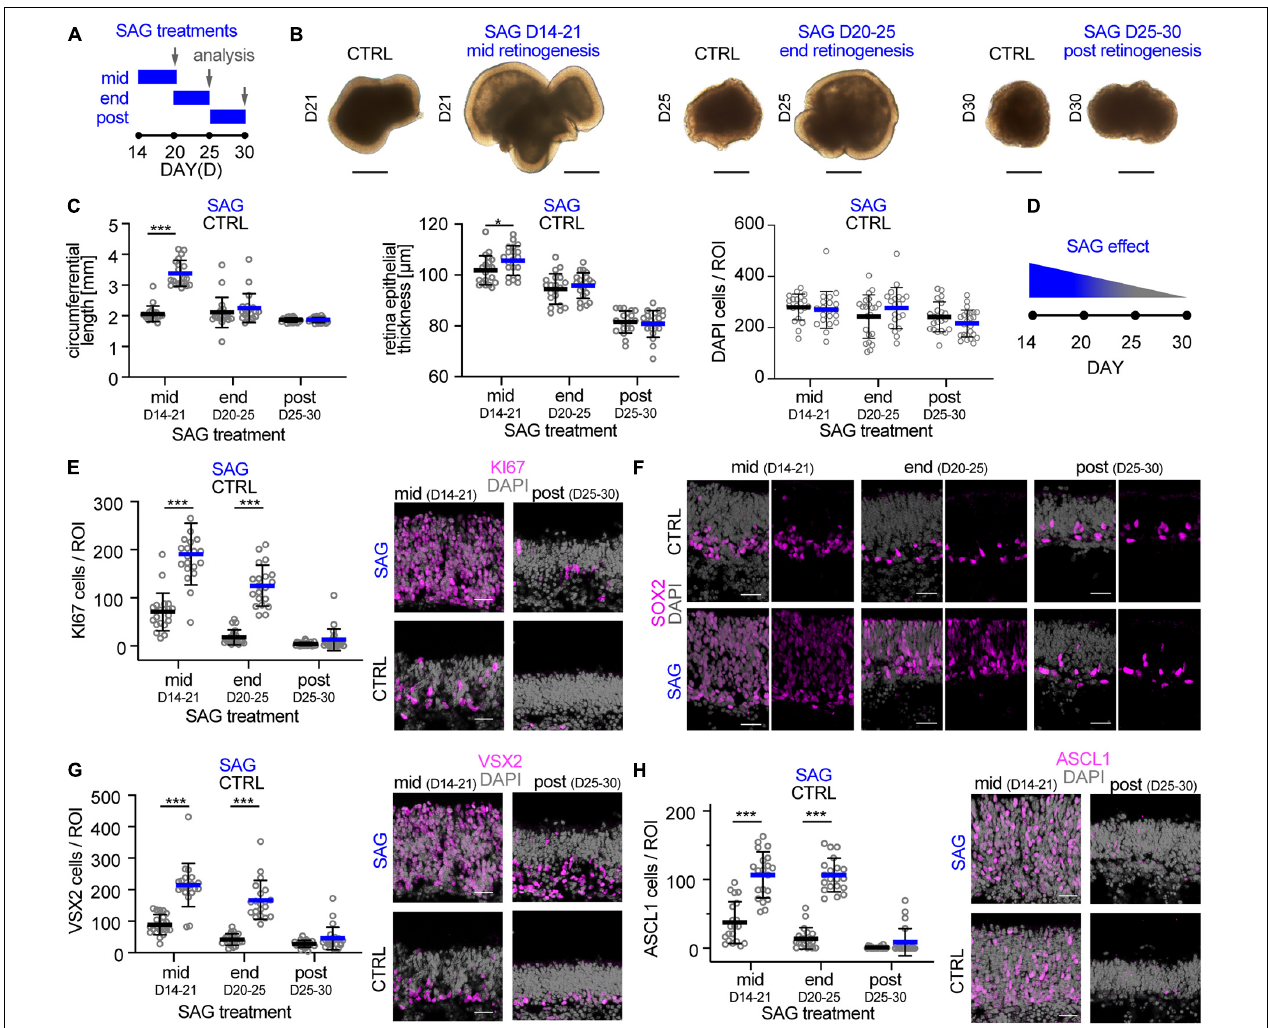
FIGURE 8 | Experimental stimulation of cell proliferation for MRO enlargement. (A) Schematic of the experimental paradigm. Mouse retina organoids (MROs) were cultured with smoothened agonist SAG starting at mid (D14), end (D20) and post (D25) retinogenesis, and analyzed on D21, 25, and 30, respectively. (B) Representative phase contrast images of SAG treated and untreated (CTRL) MRO showing increase in organoid size at mid retinogenesis, but not at later timepoints. (C) Quantification of organoid circumference and epithelial thickness in entire MRO cryosections, as well as of total cells (DAPI) in regions of interest (ROI) of 100 µ m width. Data confirms the increase of MRO size and epithelia thickness upon SAG treatment at mid retinogenesis, but not later. However, total cell counts per ROI do not increase, suggesting an expansion in epithelial length. (D) Summary schematic of the SAG induced effect on MRO. (E–H) Representative images and (E,G,H) quantification of KI67 (cell cycle marker), SOX2 (progenitors and Müller glia), ASCL1 (progenitors), and VSX2 (progenitors and bipolar cells) in untreated (CTRL) MROs and MRO treated with SAG. KI67 and SOX2 are upregulated in MRO treated with SAG at mid and end retinogenesis, but not post retinogenesis. The same is seen for ASCL1 and VSX2, however, VSX2 does also slightly increase in some SAG treated MRO at post retinogenesis. The potential of SAG to induce MRO growth declines rapidly with MRO age and maturation. * p < 0.05, *** p < 0.0001; D, day. Scale bars: (B) 500 µ m, (E − H) 25 µ m.